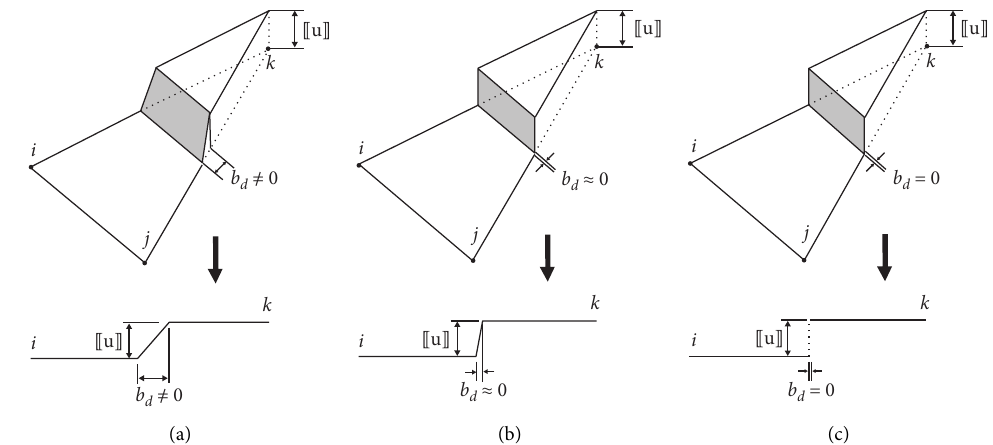
Figure 3: FEM mesh of a solid with an internal crack.